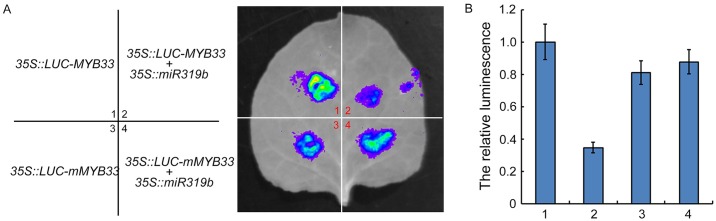
MYB33 is miR319b target.(A) Luciferase assays showing that gene expression of MYB33 is down regulated in the presence of miR319b precursor. Agrobacterium containing MYB33 or mutated mMYB33 CDS fused to 35S::LUC 3’UTR with or without Agrobacterium harbouring constructs containing the miR319b precursor were injected in to N. benthamiana plants. After 3 days, The leaves were sprayed with 500 μM luciferin and placed in the dark for 5 min. Luciferase activity was observed. (B) Quantitative measurement of luciferase intensity in different treatments as indicated in the figure. 3 biology replications have been done.